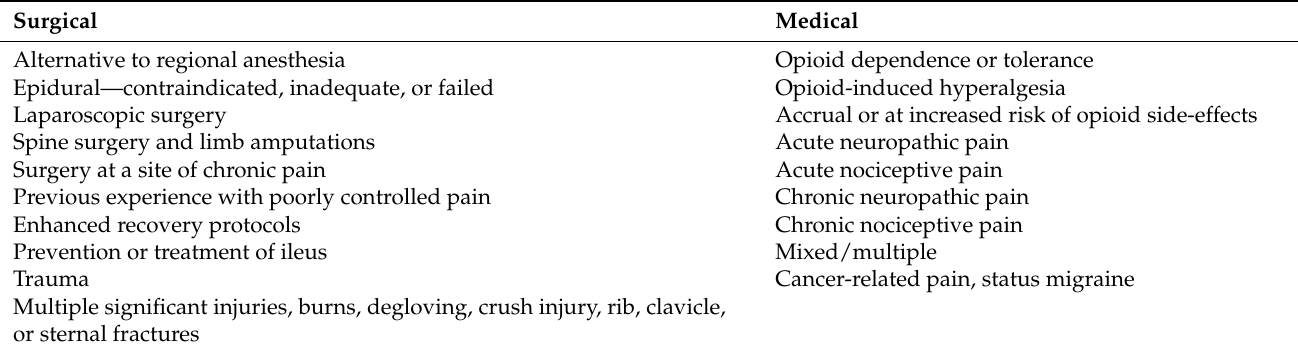
Table 1. Indications for systemic lidocaine infusion.